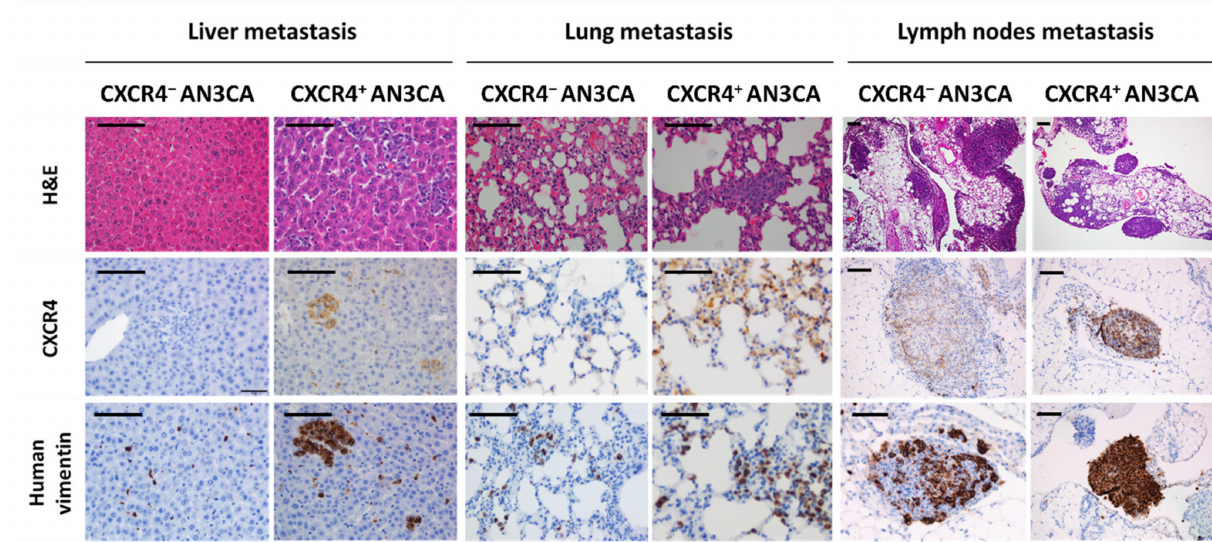
Figure 3. Dissemination pattern of the xenograft orthotopic model of advanced endometrial cancer generated in NSG mice and comparison of dissemination between models derived from CXCR4 + and CXCR4 − AN3CA cells. Histology of liver, lungs and lymph nodes with possible metastatic colonization after hematoxilin-eosin (H&E) staining of tissue sections or using immunohistochemical staining for anti-human CXCR4 or anti-human vimentin. Note the dramatically higher sensitivity of the anti-human vimentin IHC staining, to spot single or clustered cancer cells in the mouse tissues as compared to anti-CXCR4 IHC or H&E-stained tissues. Bar: 100 µ m.